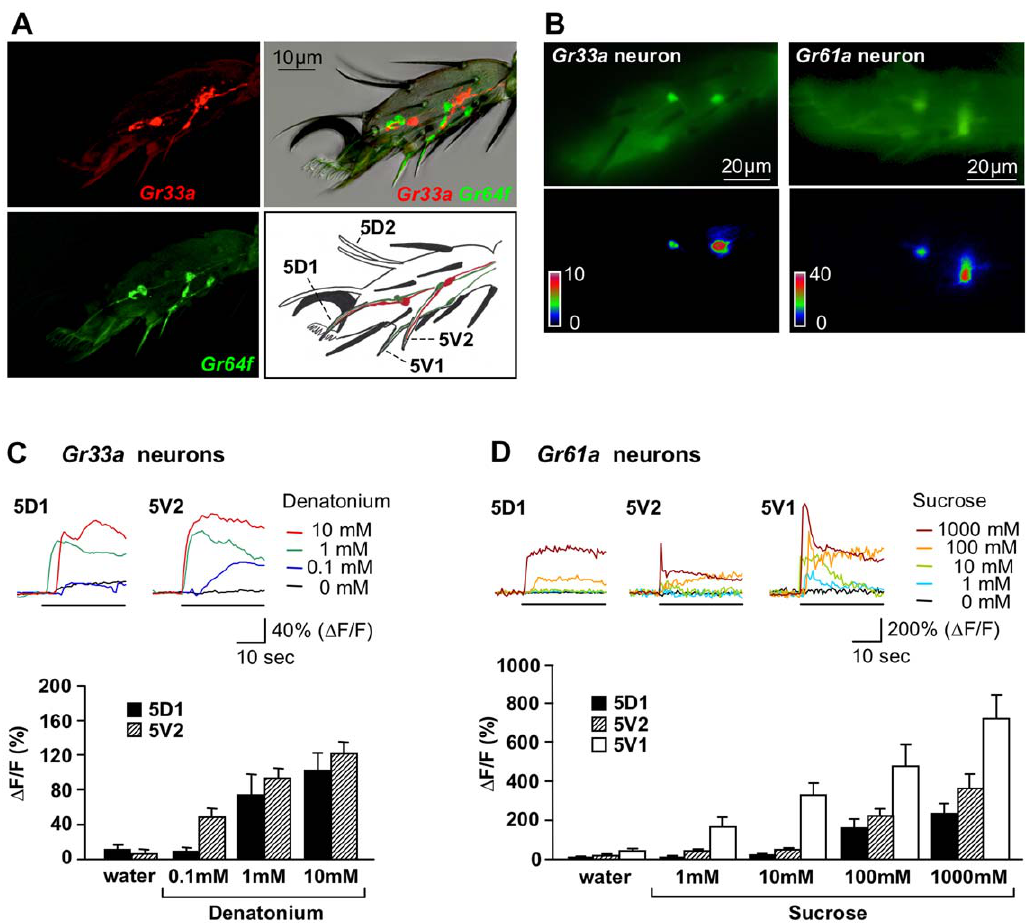
Figure 2. Concentration-dependent Ca 2 + responses of bitter and sweet neurons. (A) Expression of Gr33a GAL4 and Gr64f LexA in GRNs of the fifth tarsal segment. Gr64f LexA is completely co-expressed with Gr61a-GAL4 (JS and HA, unpublished). The image at the top right shows live expression of mCD8RFP and rCD2GFP in bitter/high salt (red) and sweet neurons (green), respectively, laid over the phase-contrast image. Identification of neural processes is possible in the images where the two fluorescent markers are visualized separately. Note that the 5V1 sensilla contain only a Gr64f , but not a Gr33a- expressing neuron. The drawing identifies each of the chemosensory sensilla. Also, only one chemosensory bristle/neuron of each pair is visible from a side view, with the exception of 5D2, which harbors neither a Gr33a GAL4 nor a Gr64f LexA Gr expressing neuron. The single, long sensilla at the tip (above the claw) has a morphology typical of chemosensory bristles, but neither of the drivers is expressed in its associated neurons. Mechanosensory bristles are shown in black. (B) Images of bitter/high salt ( Gr33a ) and sweet neurons ( Gr61a ) expressing UAS-GCaMP3.0 in the 5 th tarsal segment of forelegs. The upper panels show tarsal neurons labeled with Gr33a GAL4 /UAS-GCaMP3.0 (left) and Gr61a-GAL4/UAS-GCaMP3.0 (right), respectively, before application of ligand. The lower panel shows the increase of fluorescence ( D F) coded as pseudocolor images focused on one of the neurons of each leg after application of 1 mM denatonium and 100 mM sucrose, respectively. (C) Dosage dependent intracellular calcium changes (% D F/F) of representative samples in 5D1- and 5V2- associated bitter/high salt neurons (top graph). The black line indicates stimulus application. Average of maximum responses for the pair 5D1- associated neurons were similar and pooled, as were the responses for the pair 5V2- associated neurons (bottom graph). Genotype: Gr33a GAL4 /UAS-GCaMP3.0. 3 , n , 12; ANOVA: * p , 0.05, ** p , 0.001. (D) Dosage dependent intracellular calcium changes (% D F/F) of representative samples in the 5D1-, 5V1- and 5V2- associated sweet neurons (top graph). The black line indicates stimulus application. Average of maximum responses for neurons of a given pair were similar and therefore pooled (bottom graph). Genotype: Gr61a-GAL4/UAS-GCaMP3.0. 7 , n , 12; ANOVA: * p , 0.05, ** p , 0.001.